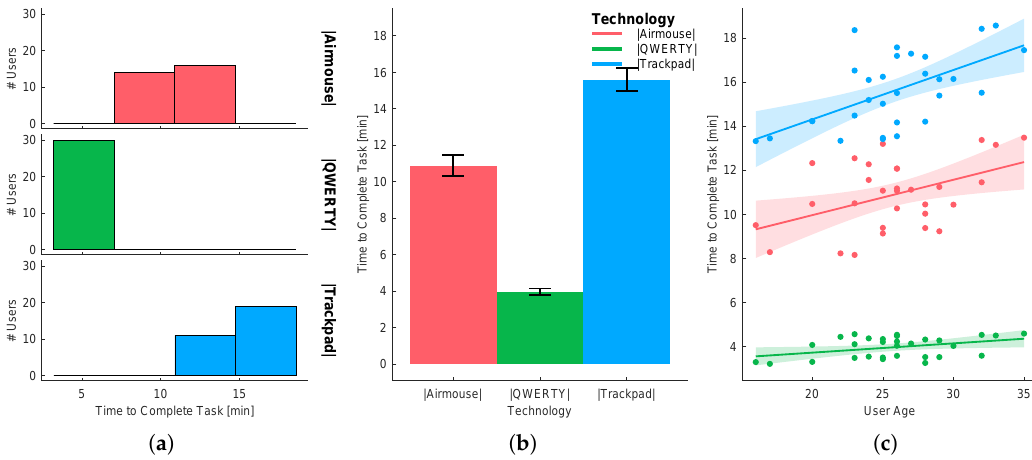
Figure 9. Task 5-time needed for typing the word “ronaldo” using three different haptic technologies: ( a ) distribution per treatment, ( b ) mean and standard deviation, ( c ) evaluation function of users’ age. Comparison with Related